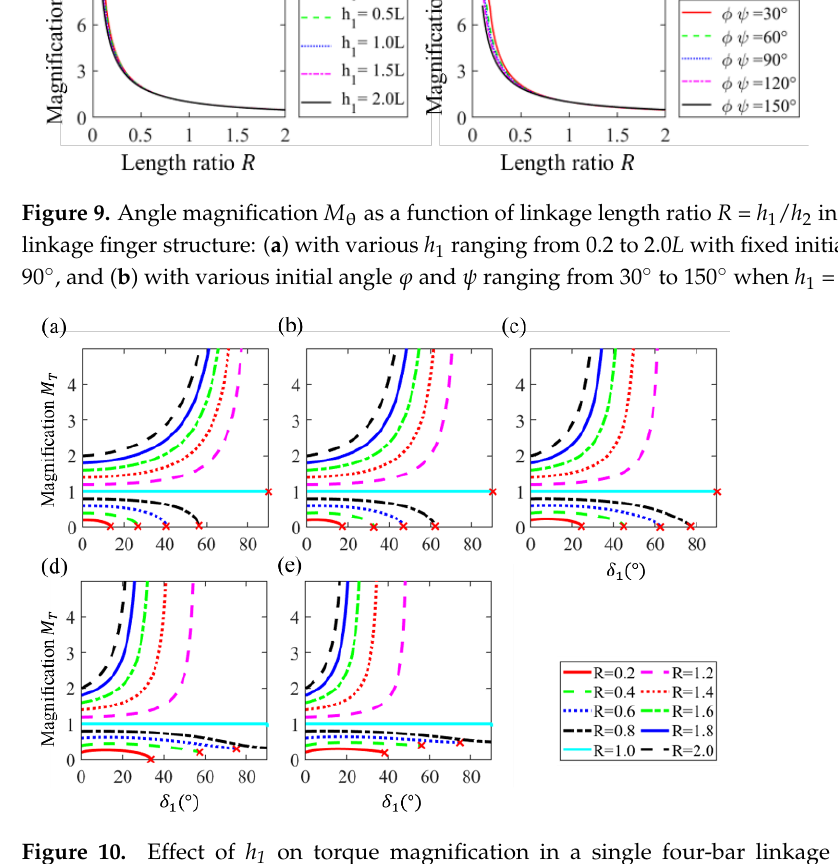
Figure 9. Angle magnification M θ as a function of linkage length ratio R = h 1 / h 2 in a single four-bar linkage finger structure: ( a ) with various h 1 ranging from 0.2 to 2.0 L with fixed initial  and 𝜓 an- gles 90°, and ( b ) with various initial angle  and 𝜓 ranging from 30° to 150° when h 1 = 0.5 L .